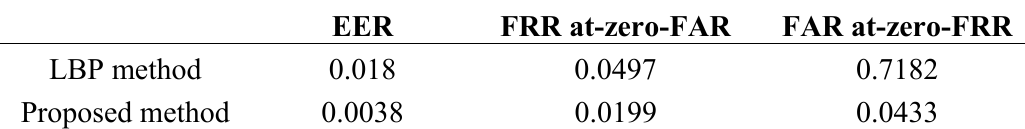
Table 3. verification performance by different methods.